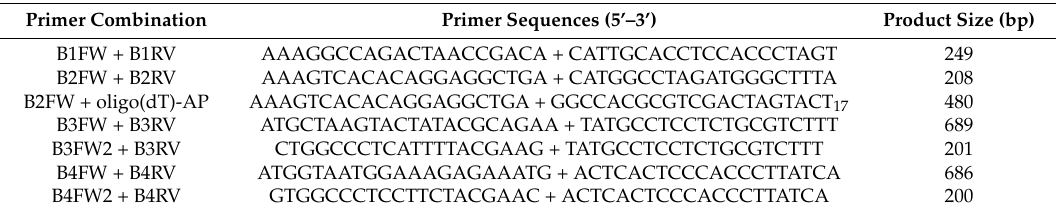
Table 1. Primer combinations used in PCR amplifications and relative dimensions of PCR products. Primer